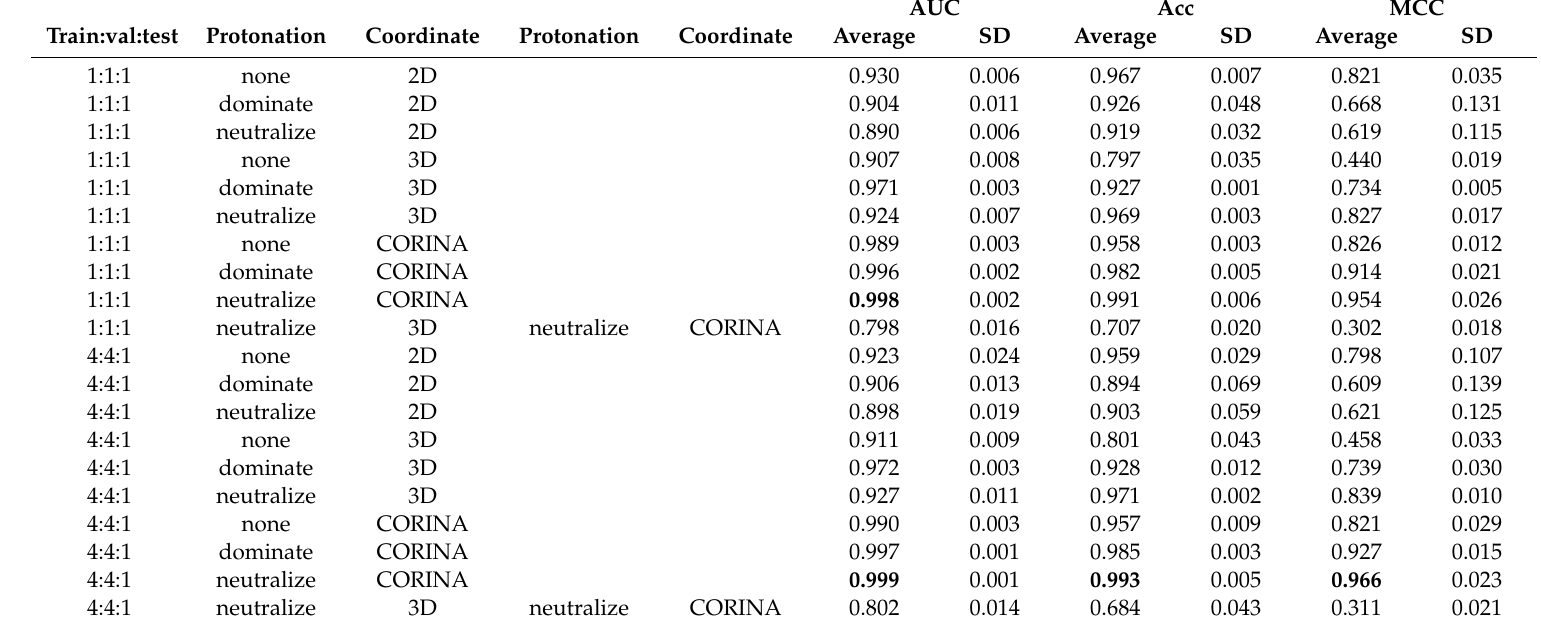
Table 1. Prediction performances with di ff erent preparations of chemical structures in the